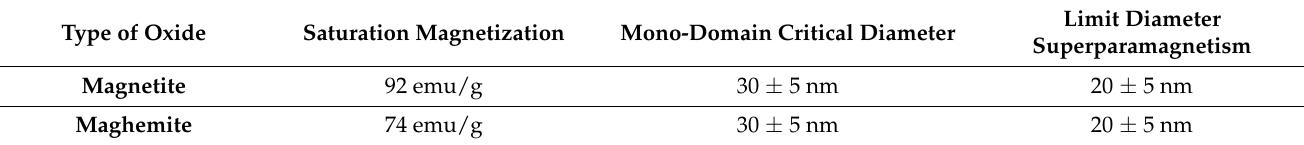
Table 1. Summary of the magnetic properties of magnetite and maghemite iron oxides.